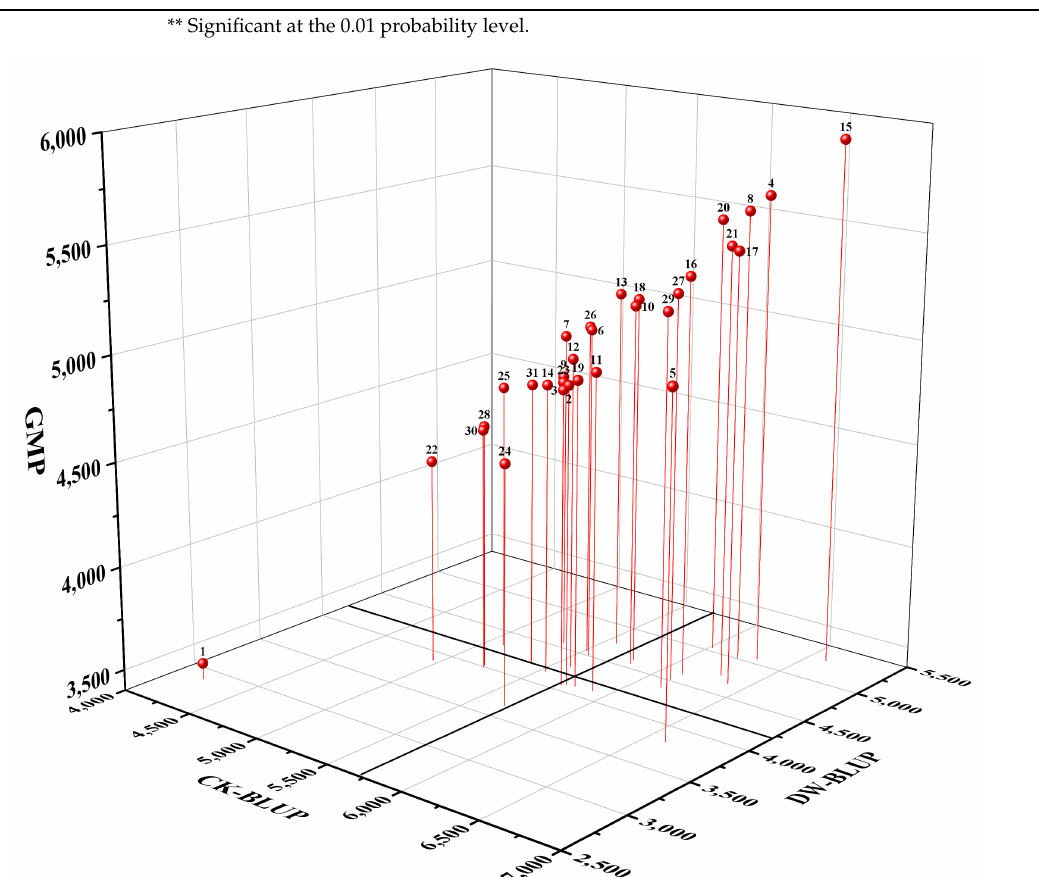
Figure 2. Three-dimensional map of inbred lines based on yield and drought tolerance.